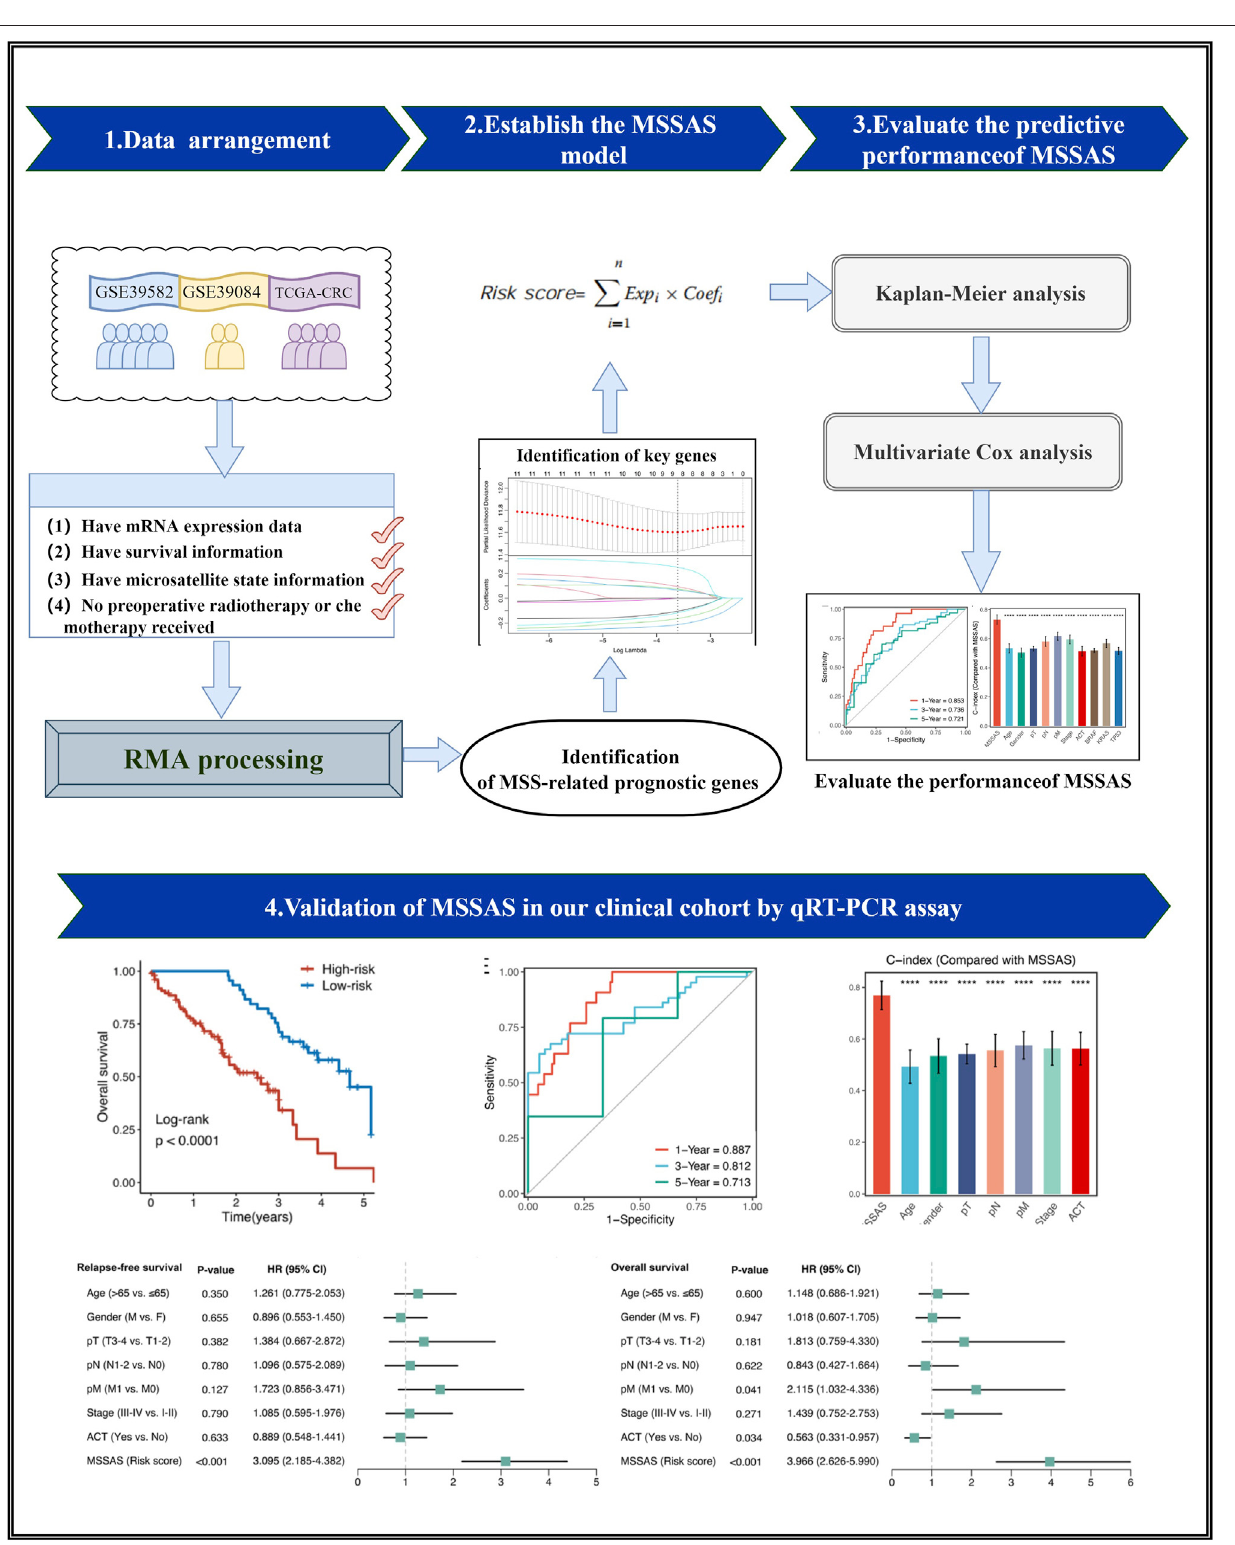
FIGURE 1 | The fl owchart of this study.